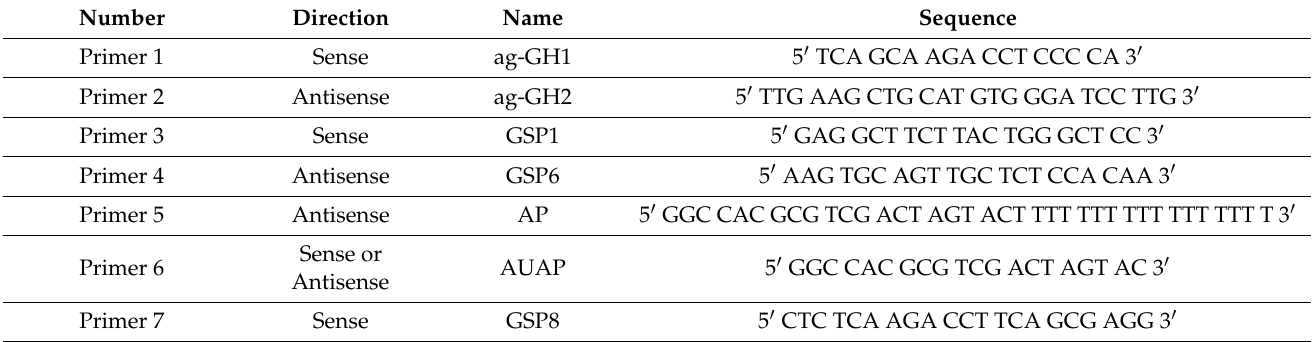
Table 1. Primers used in the cloning of A. gigas growth hormone.